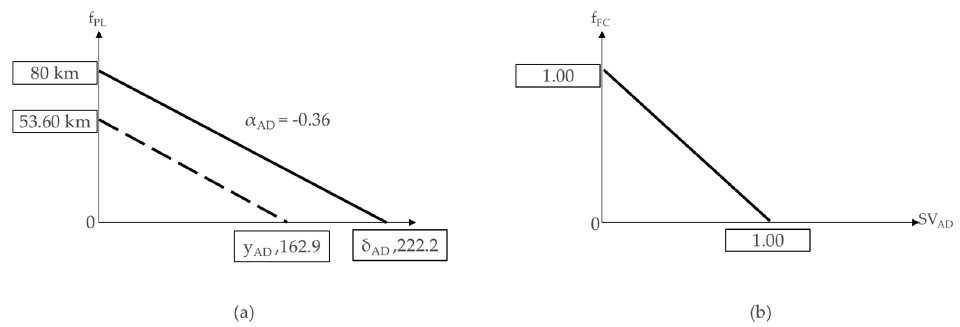
Figure 16. Adjustment factor development ( a ) and standardization for the existence ( b ) of the number